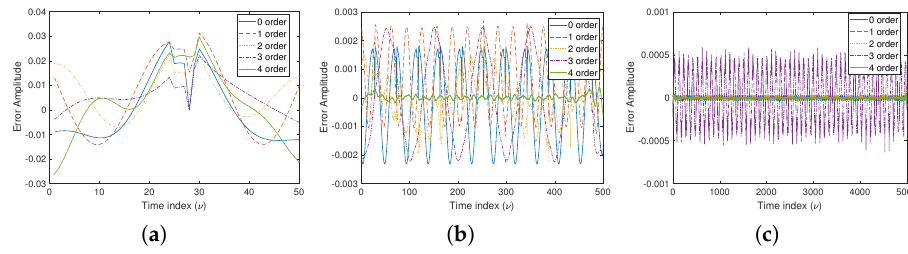
Figure 3. Error of ρ n ( ν , R Q ) ∗ p n ( ν , R Q ) with length L = ( a ) 25, ( b ) 250 ( c ) 2500.